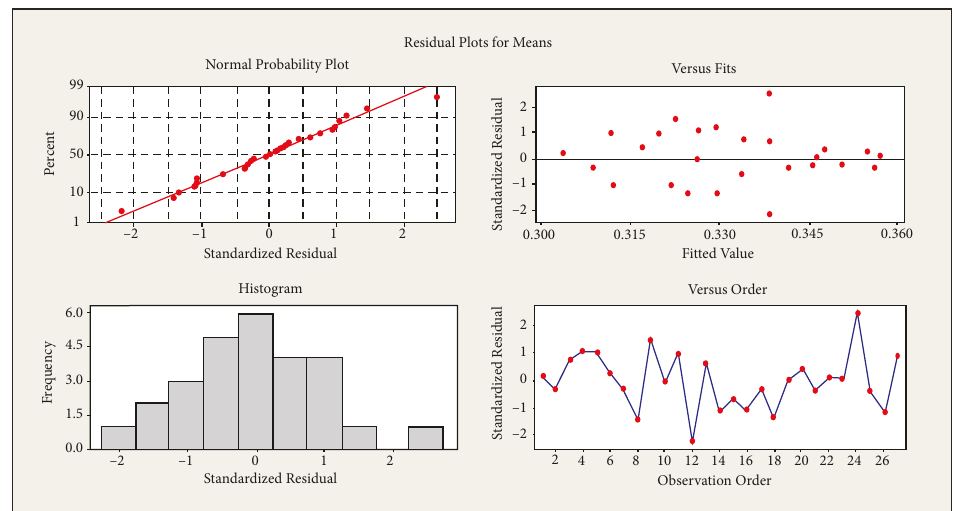
Figure 17: Residual plots for